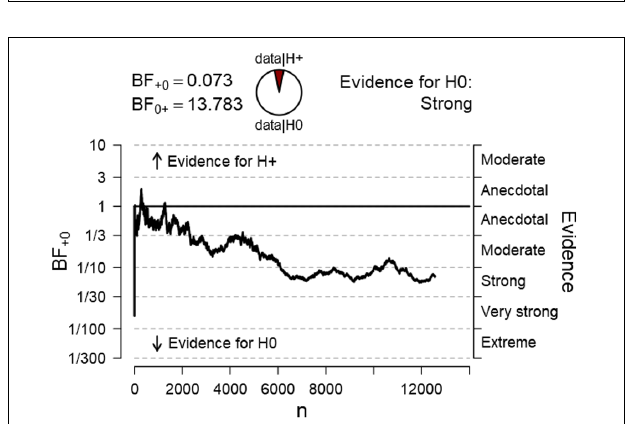
FIGURE 4 | Approximated harmonic oscillation function for the data from all 12,529 participants.